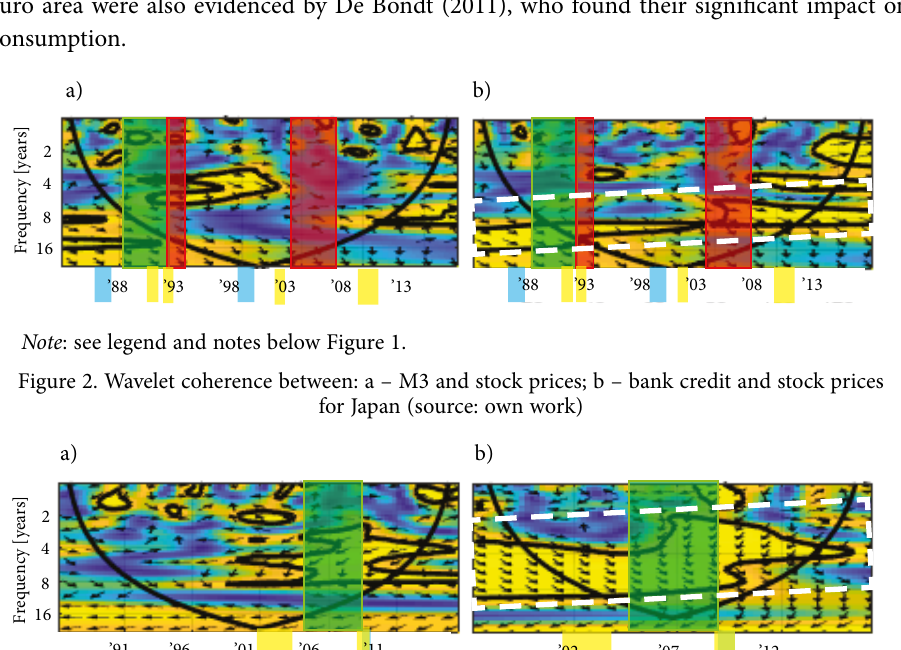
Figure 3. Wavelet coherence between: a – M3 and stock prices; b – bank credit and stock prices for the euro area (source: own